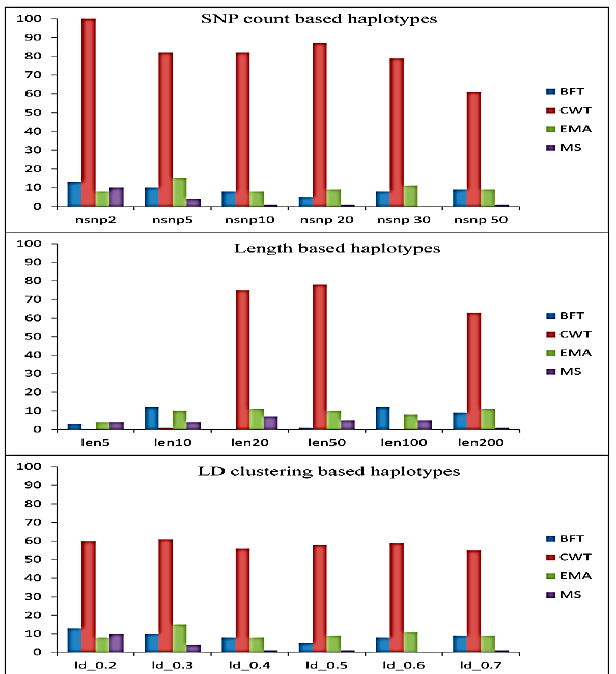
Figure 1. Number of significant haplotype blocks identified from GWAS for the four carcass traits by three different methods. SNP: Single nucleotide polymorphism, nsnp: number of SNPs in each block, Len: length in kilo base pair (Kb), LD: linkage disequilibrium, BFT: back fat thickness, CWT: carcass weight, EMA: eye muscle area, and MS: marbling score.